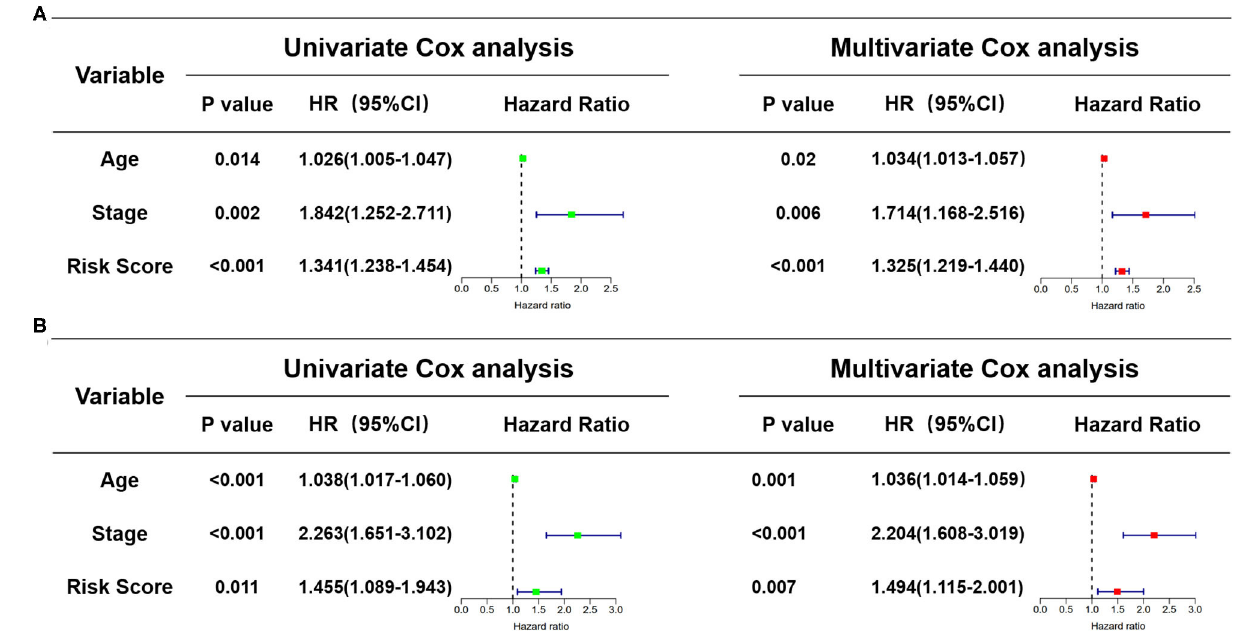
FIGURE 11 | Identification of the independence of risk score prognostic model by the Cox regression analyses. (A) The univariate and multivariate Cox regression analyses of the risk score in the training cohort. (B) The univariate and multivariate Cox regression analyses of the risk score in the test cohort. The green boxes represent risk factors of the univariate Cox regression analysis and the red boxes represent risk factors of the multivariate Cox regression analysis.